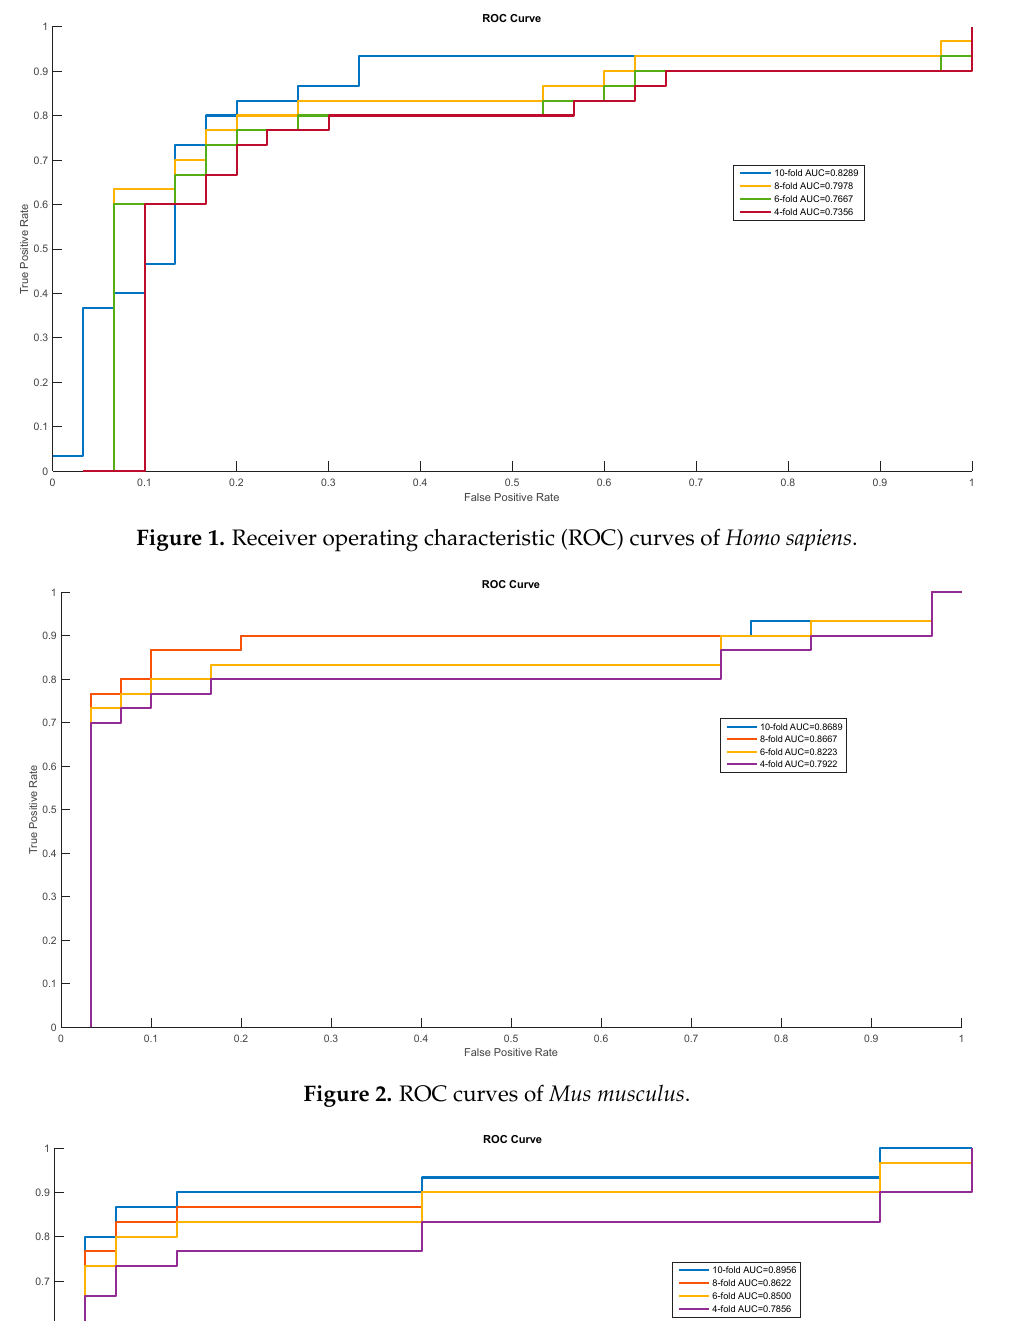
Figure 2. ROC curves of Mus musculus .